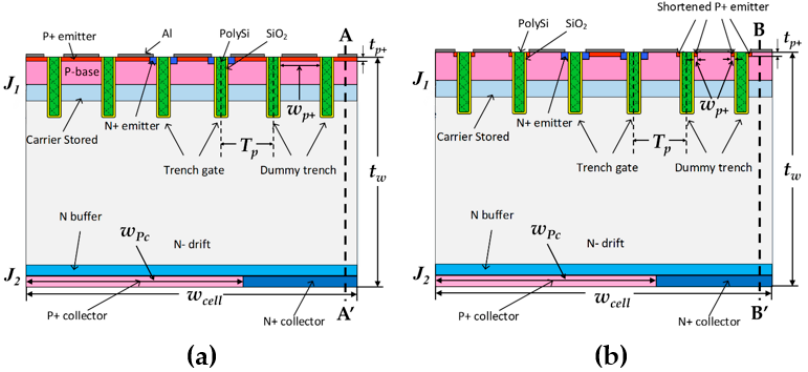
Figure 1. The cross-section of RC-IGBT. ( a ) Conventional RC-IGBT; ( b ) The proposed SE RC-IGBT. The turn-o ff current density characteristics and an approximate representation of